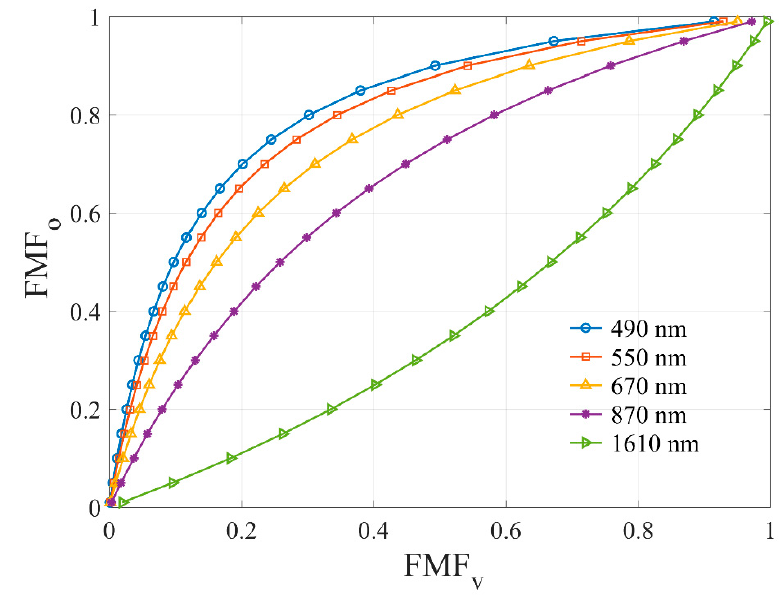
Table 2. The aerosol model parameters adopted for simulation and inversion in this paper.